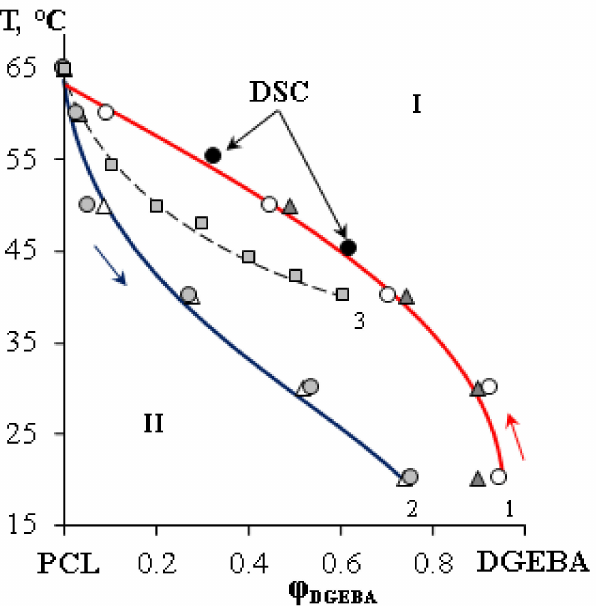
Figure 5. Phase state diagram of the PCL–DGEBA system, where 1—liquidus line, 2—solidus line, 3—literature data [35]. , —compositions of coexisting phases for M n PCL = 80 × 10 3 ; , —for M n PCL = 45 × 10 3 . —melting points of the PCL–DGEBA mixture (M n PCL = 45 × 10 3 )